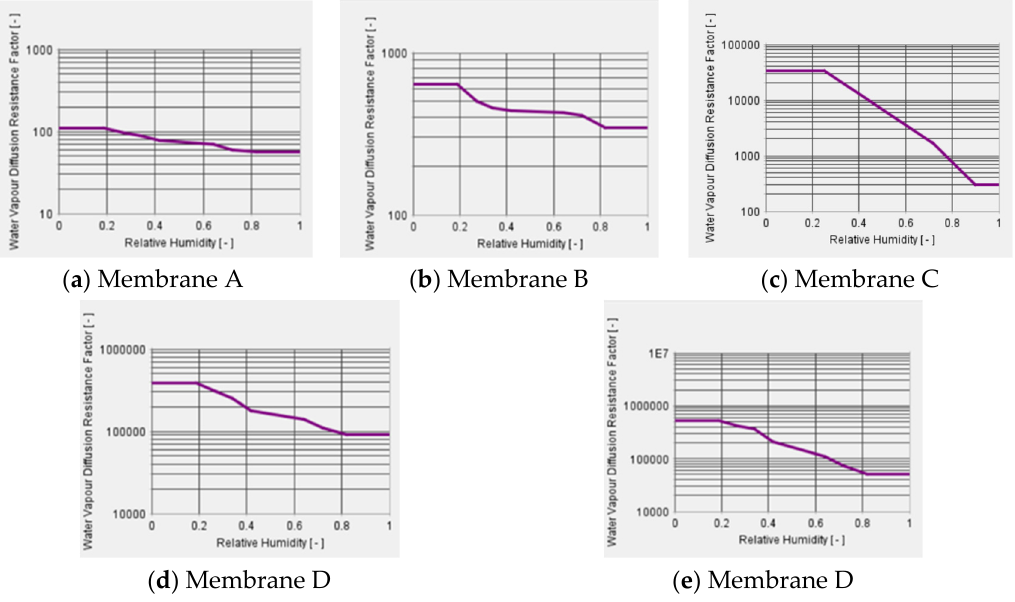
Figure 3. Multipoint vapour diffusion resistance factor graphs for five tested pliable membranes.